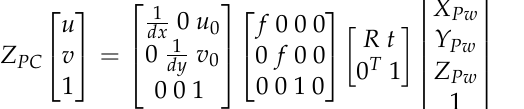
Figure 9. Coordinate system transformation.